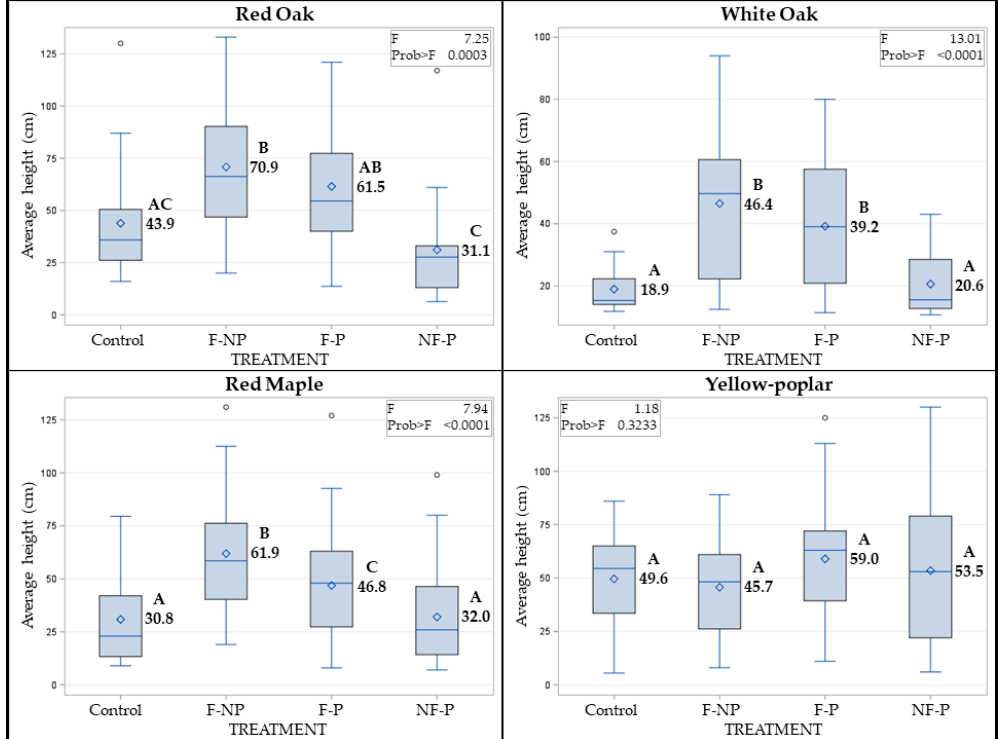
Figure 3. Box plots with mean values displayed showing the effects of wildfire and the invasive paulownia ( Paulownia tomentosa ) species on the average height of regenerating stems (<137 cm height) per hectare for red and white oaks ( Quercus sp.), red maple ( Acer rubrum ), and yellow-poplar ( Liriodendron tulipifera ). Means with the same letters (A, B, C) are not significantly different ( p = 0.05) between treatments within each species. The treatments include fire with no paulownia present (F-NP), fire with paulownia present (F-P), and no fire and paulownia present (NF-P). The treatment no fire and no paulownia present (NF-NP) serves as the control.